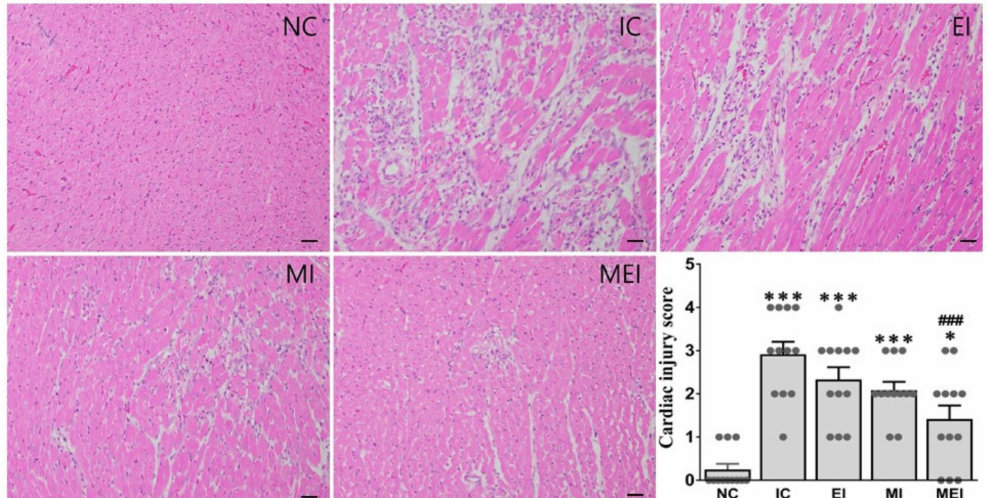
Figure 5. Effect of melatonin and exercise on histopathological changes in heart tissue. H&E staining was performed and visualized under a light microscope at × 200 magnification ( n = 4 per group). Micrograph shows that tissue necrosis and inflammatory infiltration are markedly elevated in the IC group, whereas these are effectively controlled by combined action of melatonin and exercise, as shown in the MEI group, representing their cardio-protective effect. * p < 0.05 and *** p < 0.001 versus the NC group. ### p < 0.001 versus the IC group calculated through the Bonferroni post hoc test following one-way ANOVA. NC, normal control; IC, isoproterenol control group; EI, exercise plus isoproterenol-challenged group; MI, melatonin plus isoproterenol-challenged group; MEI, melatonin and exercise plus isoproterenol-challenged group. Scale bar, 100 µ m.